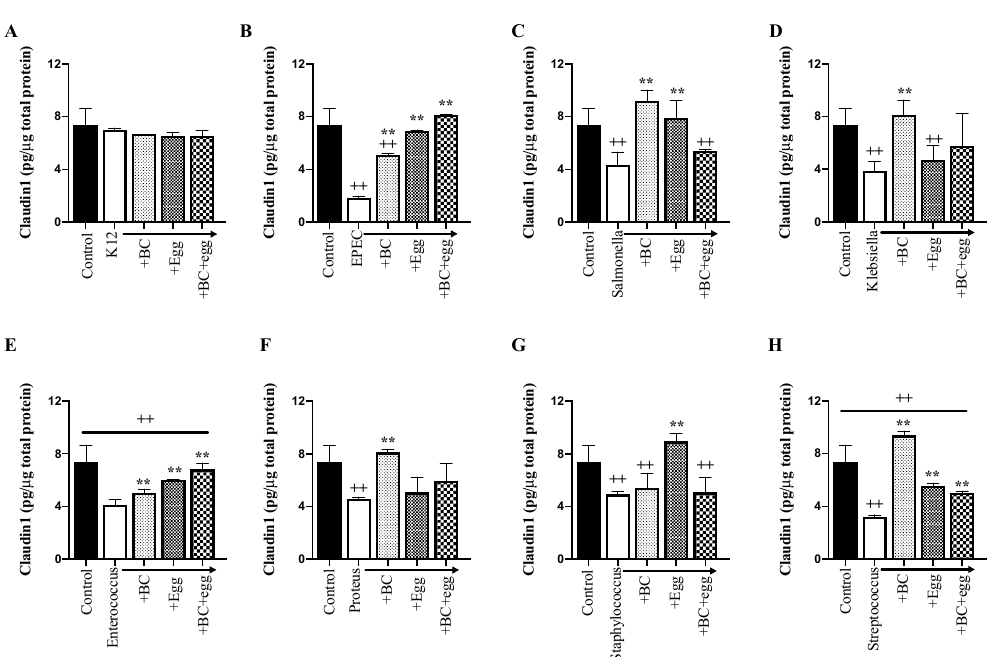
Figure 3. Effect of BC, egg, or the combination on tight junction protein, claudin-1. Bacterial strains (1 × 10 6 CFU/well) ± BC (1 mg/mL), egg (1 mg/mL), or the combination (0.6 mg/mL BC + 0.4 mg/mL egg) were added to confluent monolayers of Caco-2 cells. Cleared lysates were prepared 24 h later. Control wells received no bacteria or test product. ( A ) Escherichia coli K12 (negative control); ( B ) EPEC; ( C ) Salmonella ; ( D ) Klebsiella ; ( E ) Enterococcus ; ( F ) Proteus ; ( G ) Staphylococcus ; ( H ) Streptococcus. Results are expressed as mean ± SEM from 3 wells. ++ signifies p < 0.01 vs. non treated (without bacteria or test product) control and ** signifies p < 0.01 vs. bacteria alone.